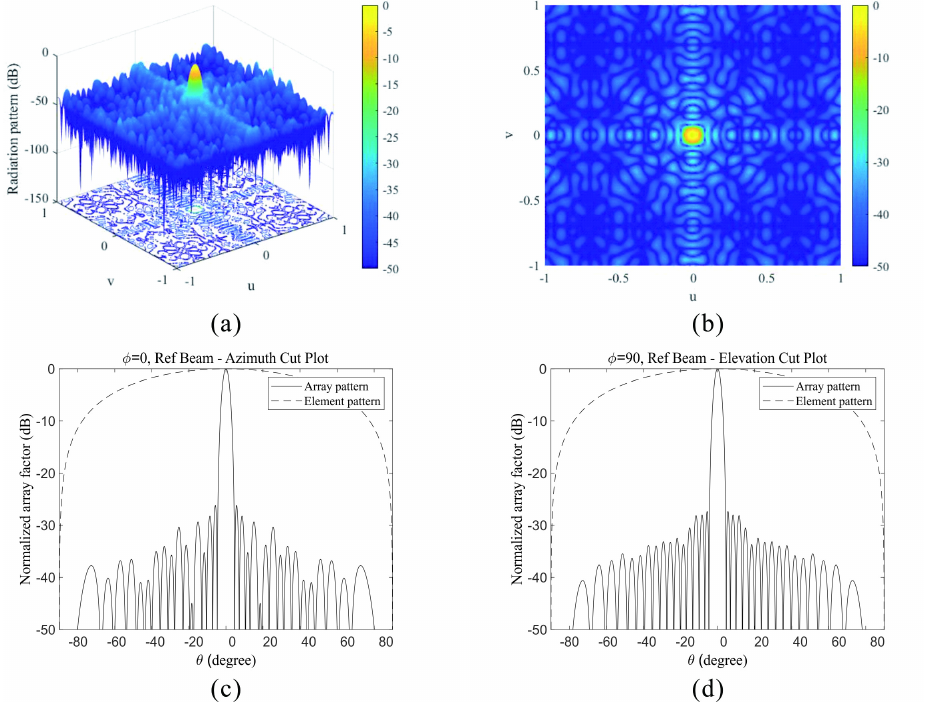
Figure 4. Radiation pattern in which optimized weighting is applied: ( a ) boresight direction in the 3-D plot, ( b ) boresight direction in the UV plot, ( c ) boresight direction at the azimuth cut, and ( d ) boresight direction at the elevation